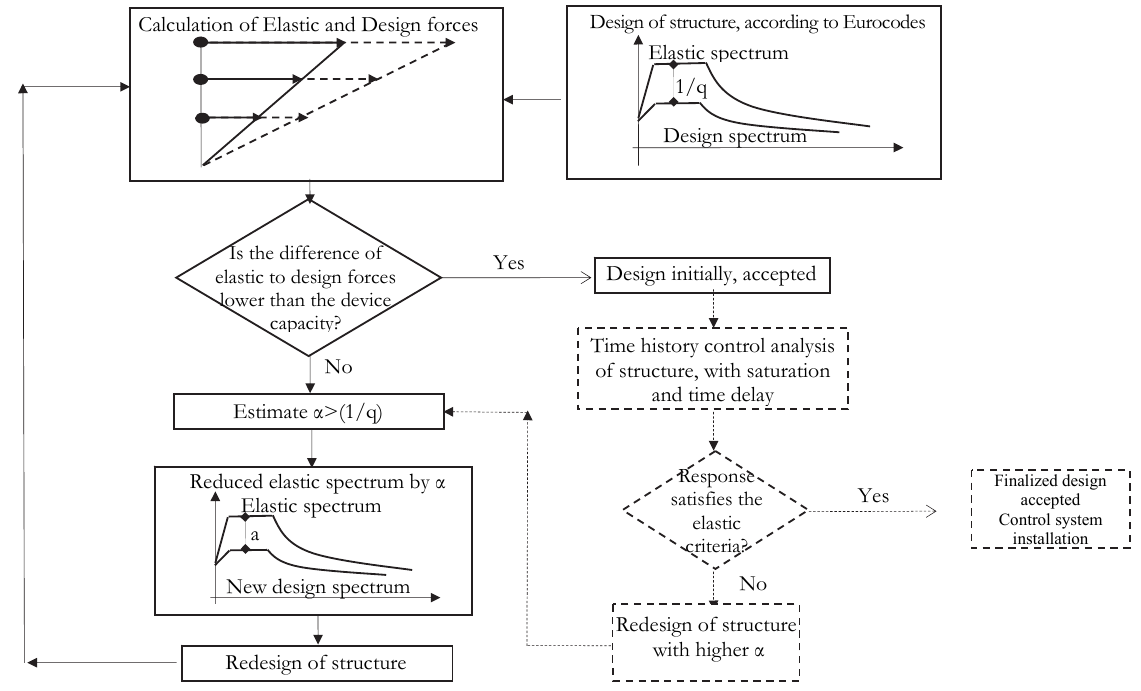
Figure 2 : The flow chart of the proposed design